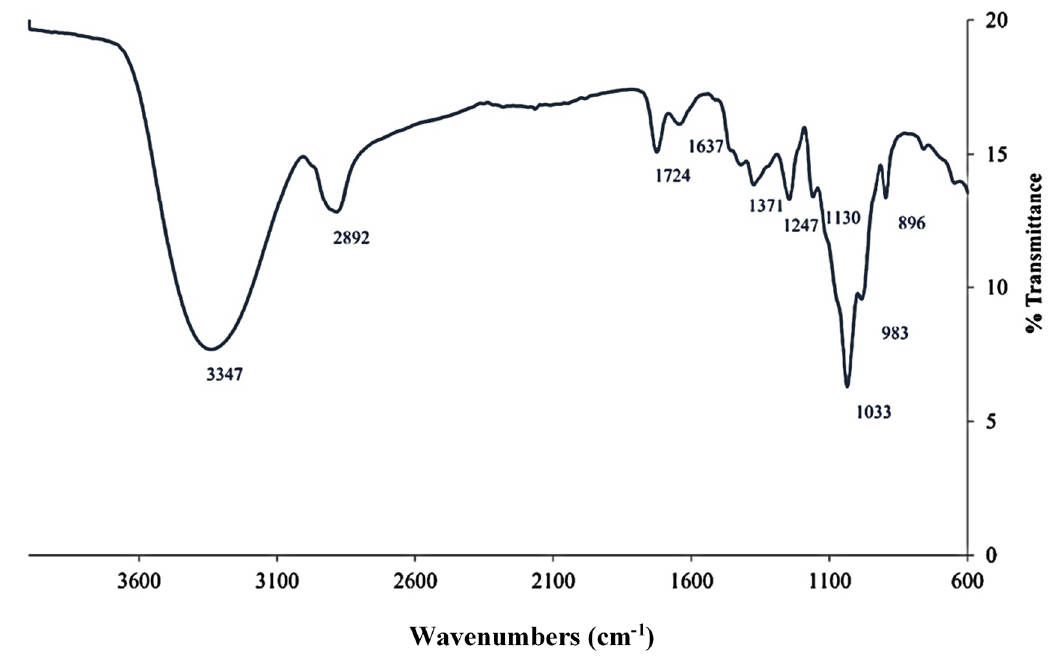
Figure 4. Spectrum FTIR.